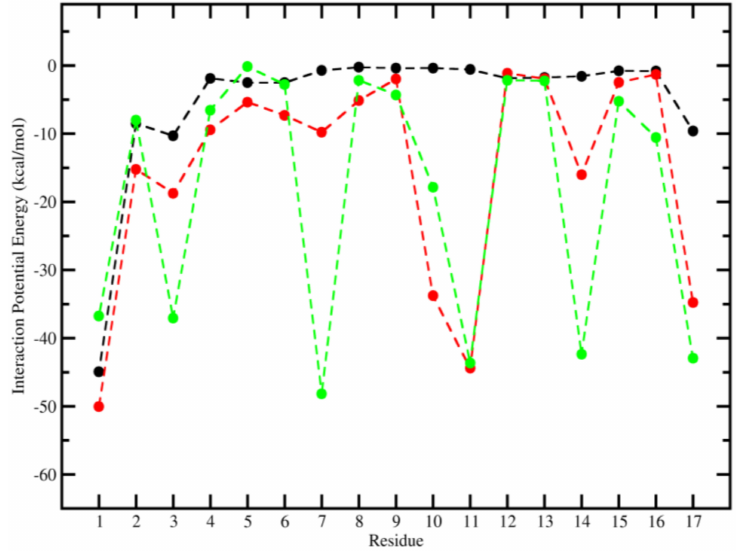
Figure 4. Interaction Potential Energy (kcal mol − 1 ) between peptide residues and lipid bilayer over the last 50 ns from MD simulations. Stigmurin (black), StigA25 (red) and StigA31 (green).